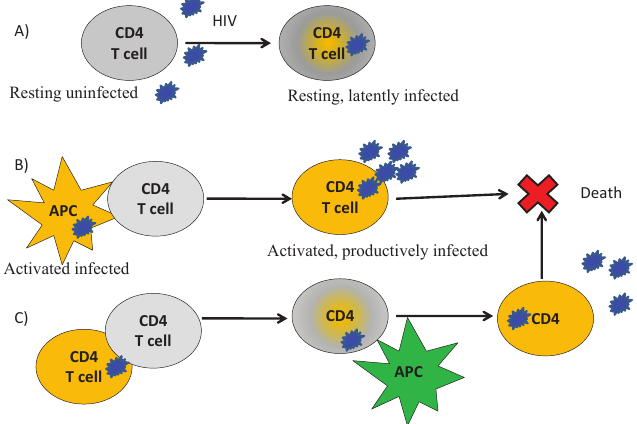
Figure 2. Scenarios of virus modes of infection of CD4 T cells. ( A ) Free virus infection of resting CD4 T cells resulting in a latent infection; ( B ) interaction between infected APC and uninfected CD4 T lymphocytes resulting in a productive infection; ( C ) cell-to-cell spread of HIV from infected to uninfected CD4 T lymphocytes resulting in a productive infection upon activation by HIV antigen-presenting APC.